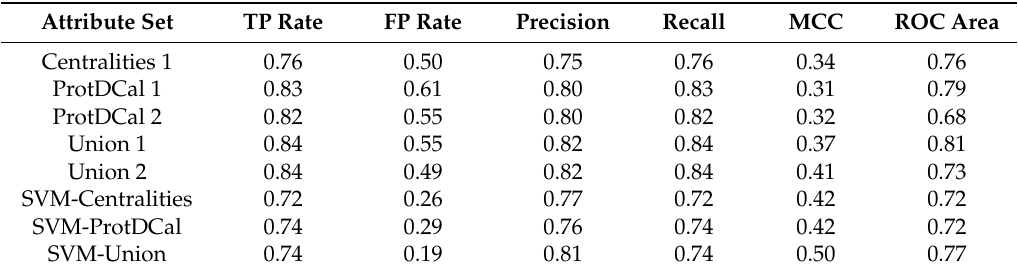
Table 7. Leave-One-Out Test for JAMMING3SET.